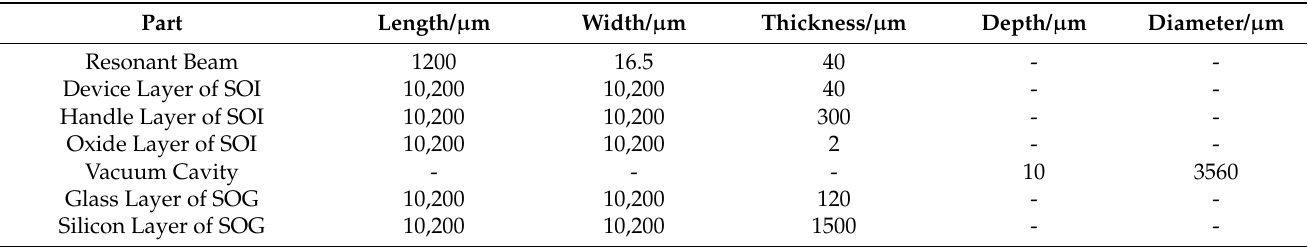
Table 4. Dimensional information of the microsensor model in FEA simulations.